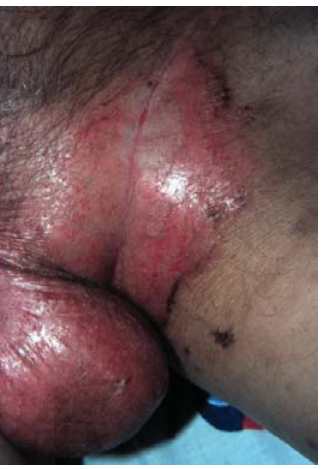
Figure 1 - Erosive scaling and crusted patches on the genital and groin area